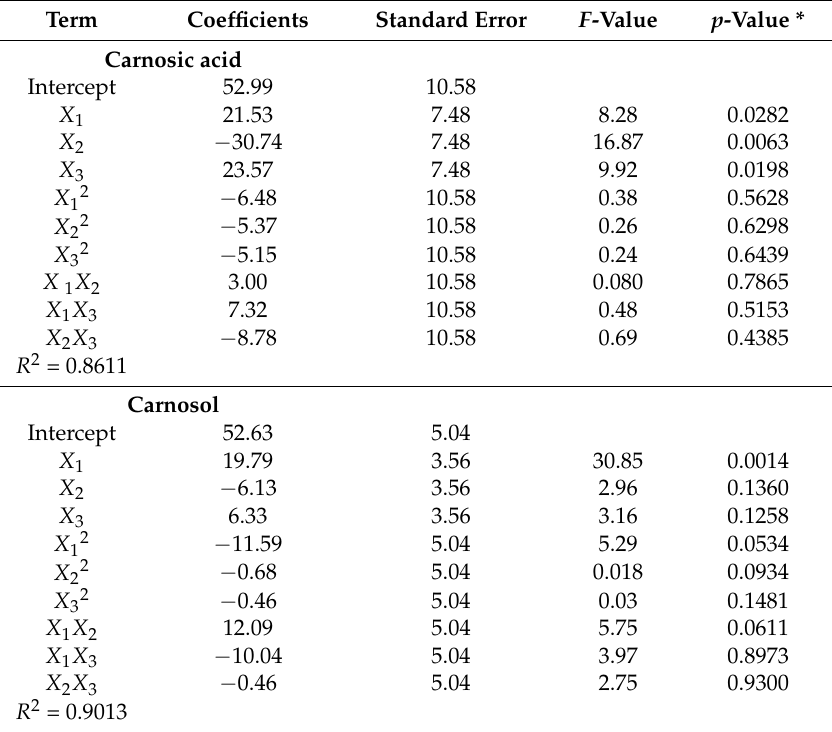
Figure 1. Three-dimensional plots for the obtained content of carnosic acid as a function of the extraction pressure and temperature. Table 3. Regression coefficient of polynomial function of all response